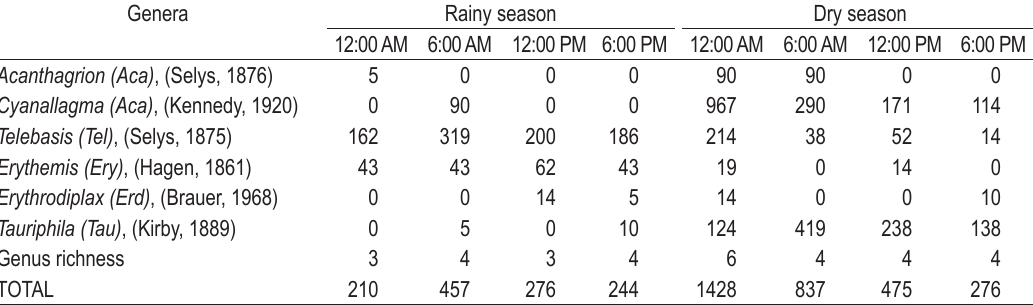
Table 1. Abundance and richness of Odonata genera sampled within macrophyte Salvinia auriculata in Cavalos Lake at different hours of nycthemeral cycle during rainy and dry seasons.